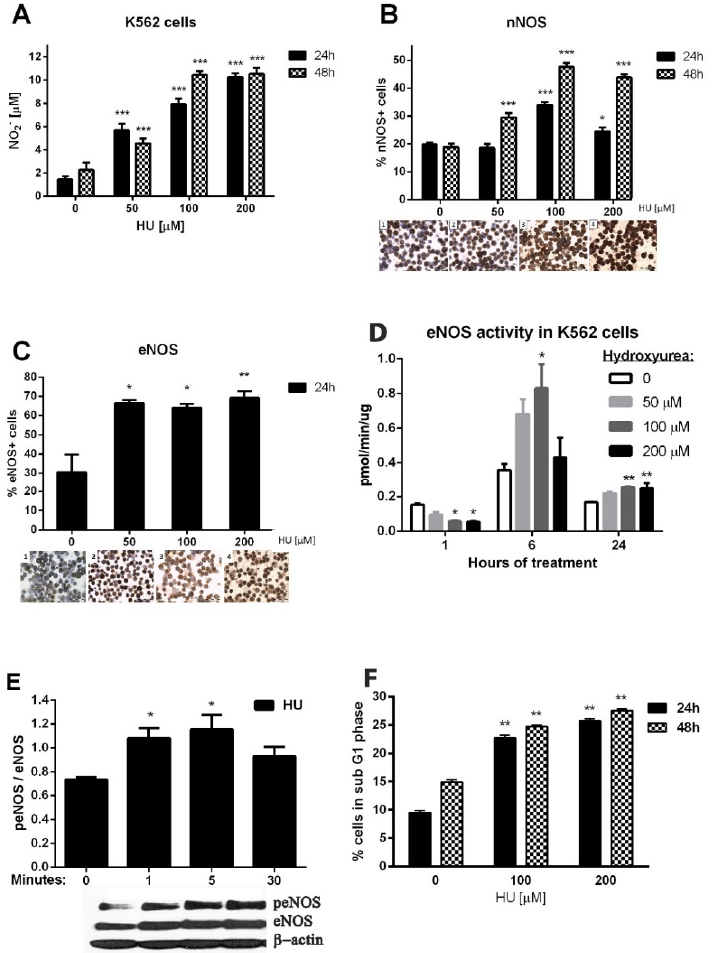
Figure 2. Hydroxyurea (HU) induction of NO in erythroleukemic K562 cells. Level of ( A ) nitrite (NO 2 − ) and quantity of ( B ) nNOS-positive cells after 24 and 48 h of treatment; ( C ) eNOS-positive cells after 24 h of incubation with HU determined by immunocytochemistry; ( D ) eNOS activity in K562 cells during treatment by HU; ( E ) peNOS/eNOS ratio after 1, 5 and 30 min of stimulation by 100 µ M HU; ( F ) Apoptotic cells in the sub G 1 phase of cell cycle determined by flow cytometry after 24 and 48 h of treatment by HU. Columns correspond to immunocytochemistry (B-after 48 h, ( C ) and immunoblot ( E ) images. Values are mean ± SEM ( n = 4–5). * p < 0.05, ** p < 0.01, and *** p < 0.001 compared to untreated